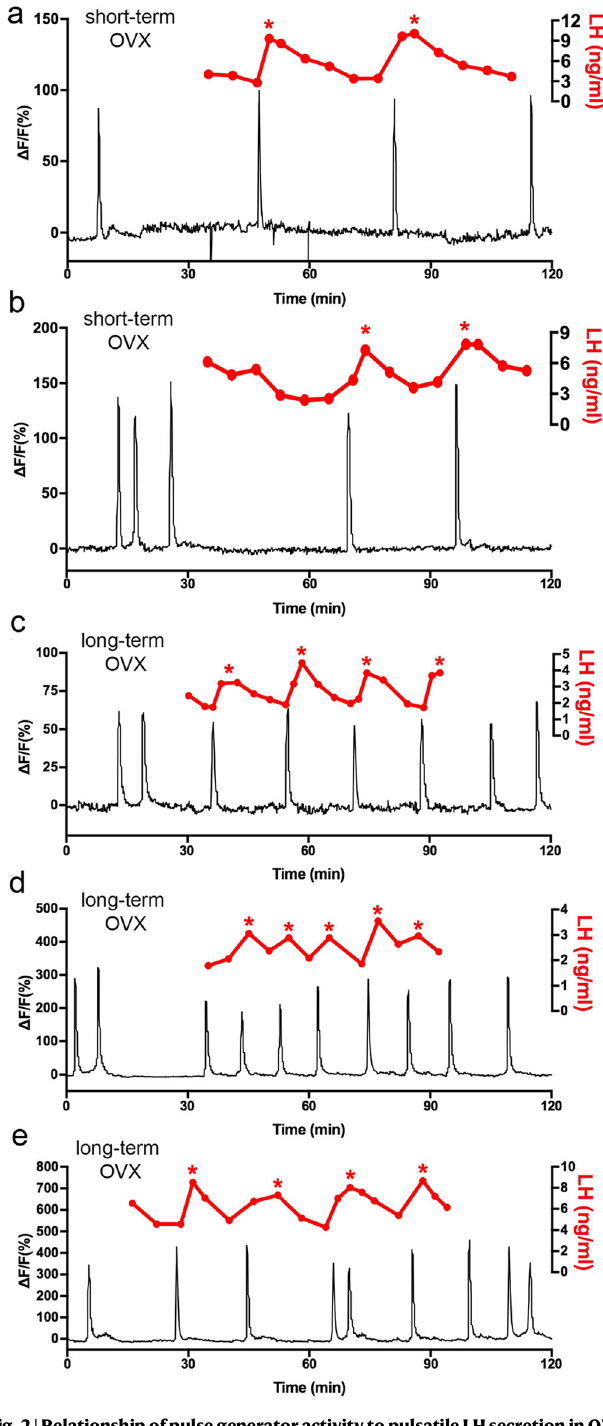
Fig.2|RelationshipofpulsegeneratoractivitytopulsatileLHsecretioninOVX mice. Representative examples from 2 short-term (~2 weeks) OVX ( a , b ) and three long-term (>4 weeks) OVX ( c – e ) mice showing the correlation between SEs recor- ded using GCaMP6 photometry and LH pulses measured from tail-tip blood sam- ples. Individual LH pulses are indicated by